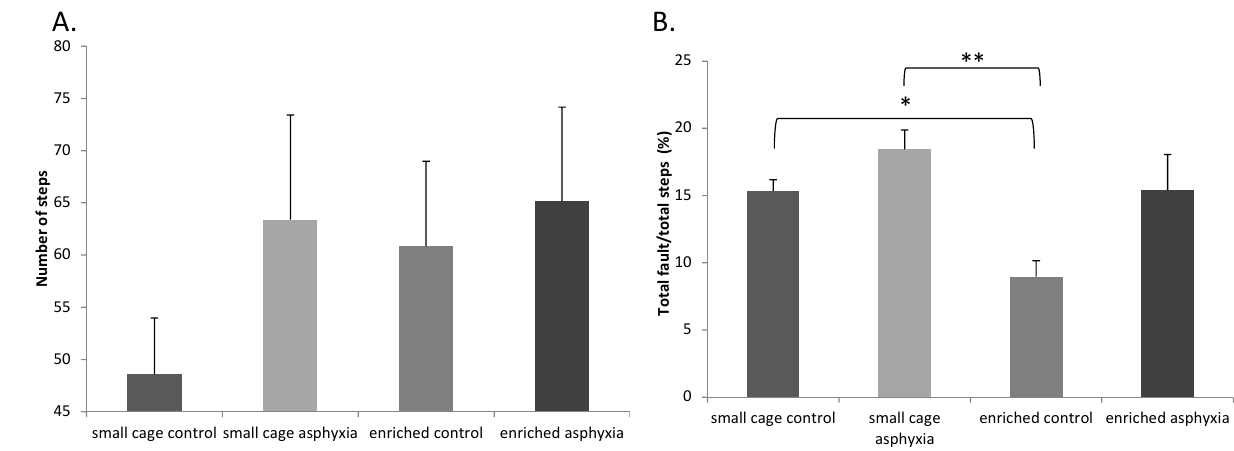
Figure 4. Motor coordination tests: Grid walking and footfault test. ( A ) Number of total steps; and ( B ) Number of total faults (* p < 0.05, ** p <